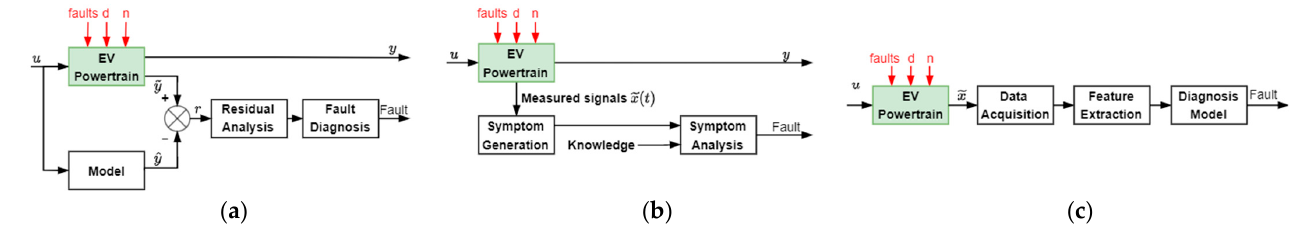
Figure 5. Scheme of different fault diagnosis methods: ( a ) Model-based methods; ( b ) Signal-based methods; ( c ) Knowledge-based methods.